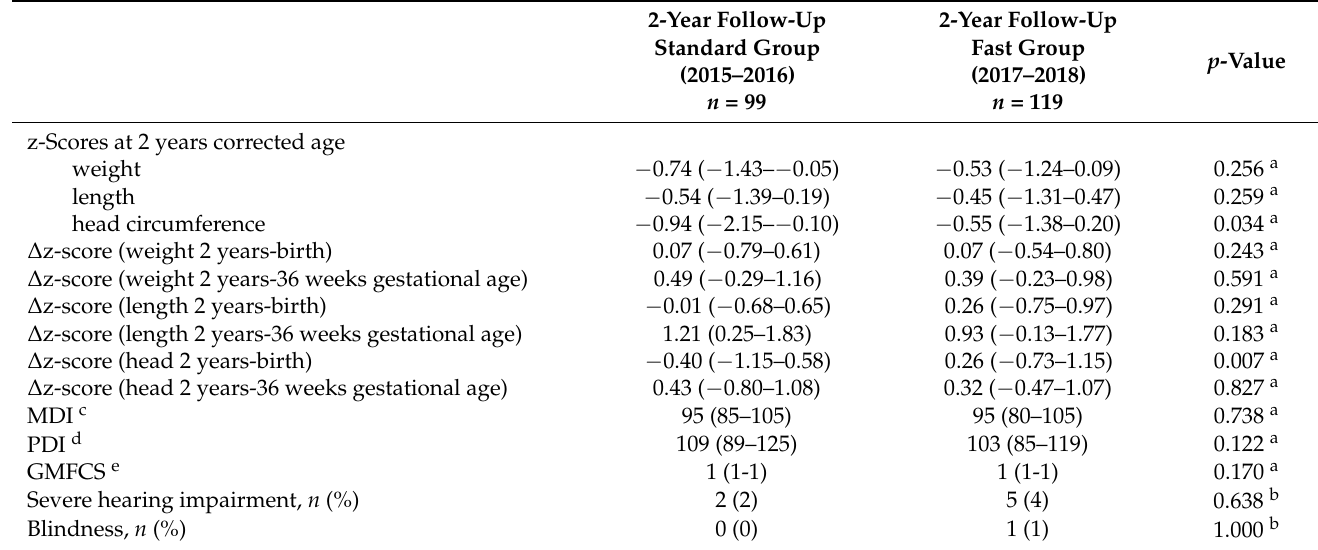
Table 3. 2-year somatic and psychomotor outcome variables in the study